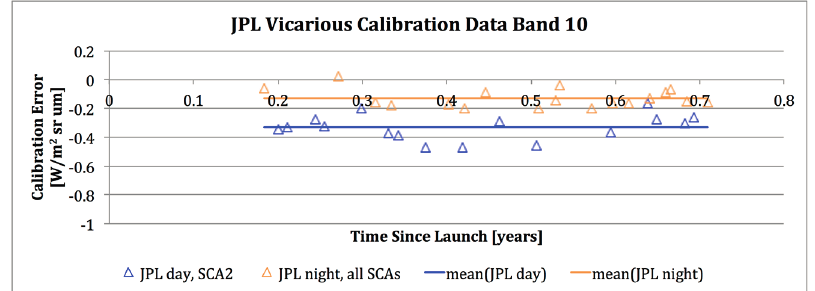
Figure 10. The initial vicarious calibration results for Band 10, based on the JPL data only, displayed as difference between the predicted vicarious radiance minus the image radiance.